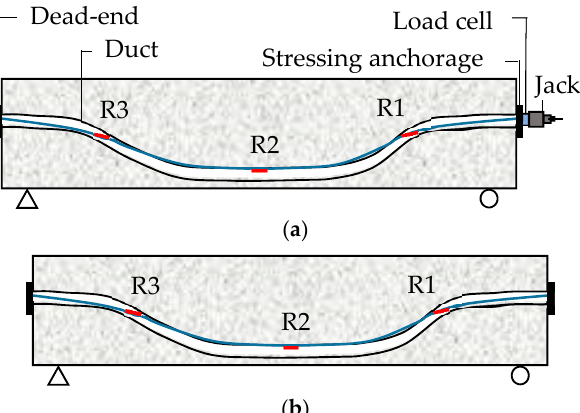
Figure 6. The schematic of the two stages of post-tensioning: ( a ) Application of tensioning to tendons; and ( b ) Fitting the wedge and cutting the